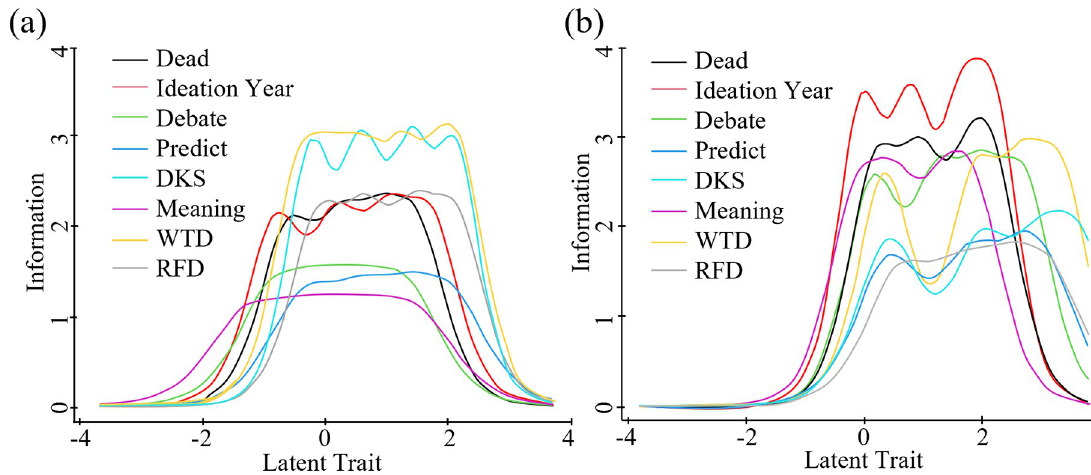
Fig 5. Suicidality Scale item information curves for study 2 (left) and study 3 (right).